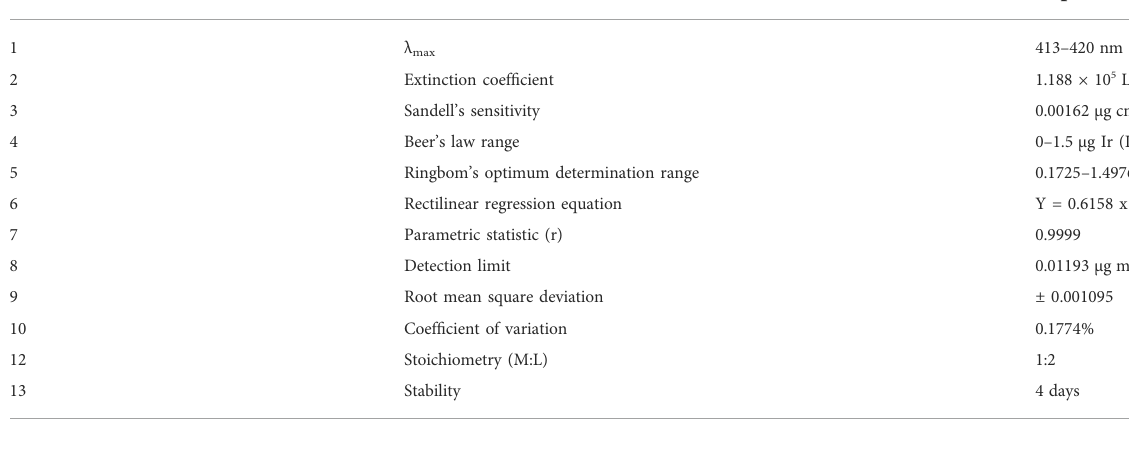
TABLE 4 Spectral and qualitative characteristics of the studied complex. S. No.